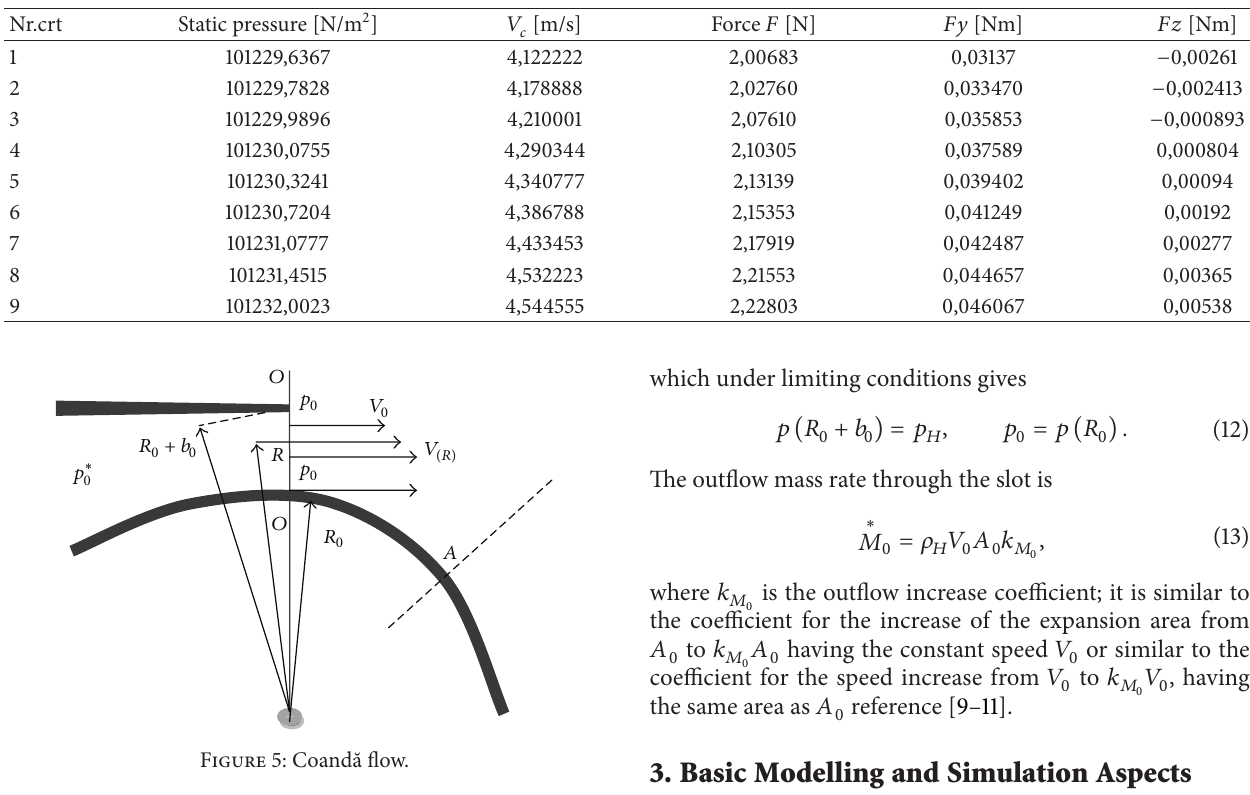
Figure 5: Coand˘a